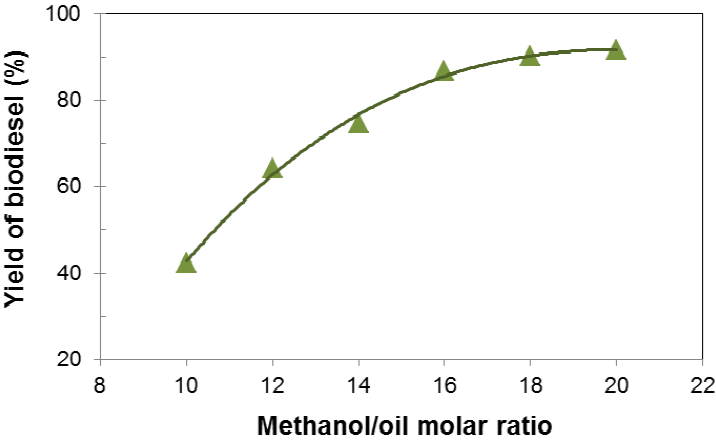
Figure 6. Effect of methanol/oil molar ratio on the yield of biodiesel in